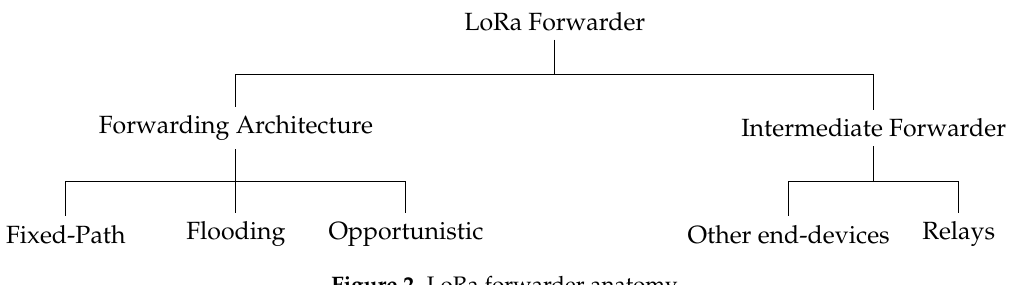
Figure 2. LoRa forwarder